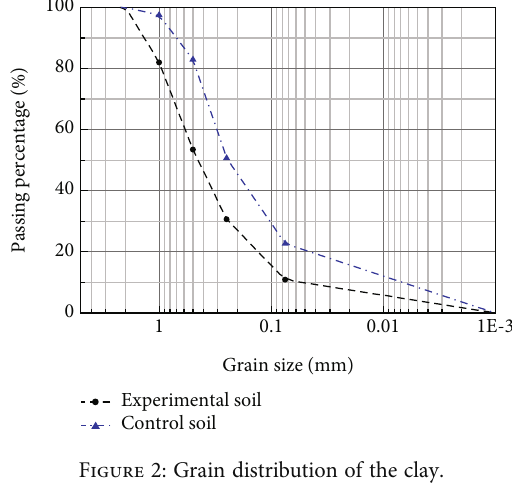
Figure 2: Grain distribution of the clay.